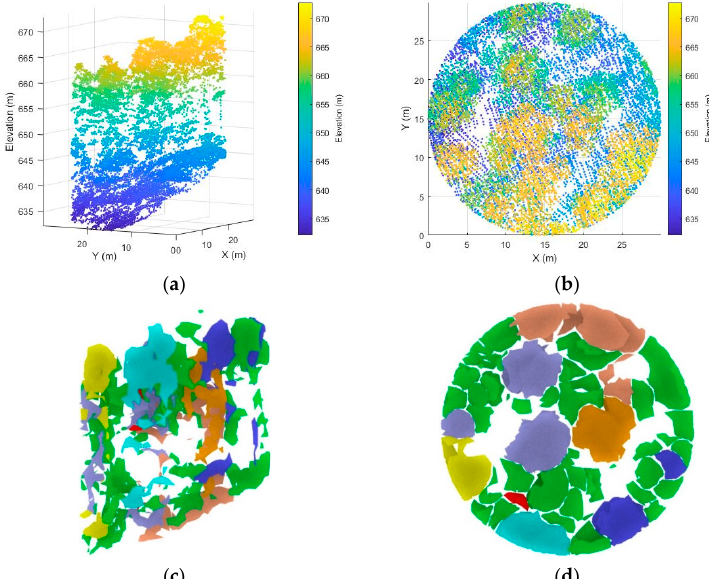
Figure 2. Original point cloud and alpha-shape in a plot: ( a ) Elevation view of the original point cloud; ( b ) Top view of the original point cloud; ( c ) Elevation view of alpha-shape for each individual wood; ( d ) Top view of alpha-shape.